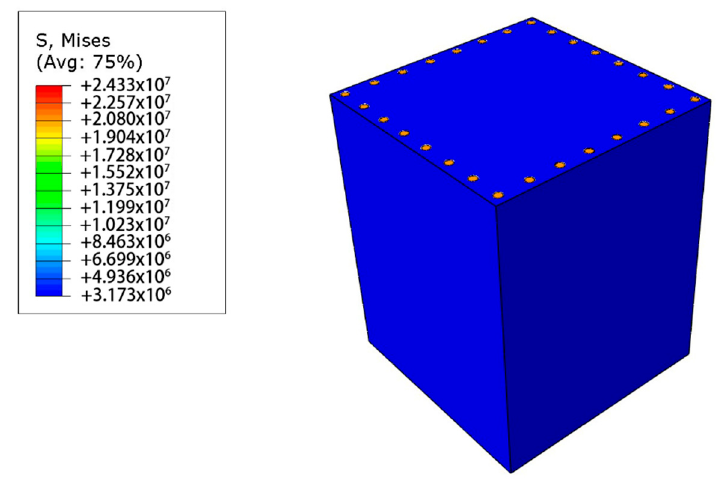
Figure 9. Stress distribution in the case of axial stress on the steel-reinforced concrete column.